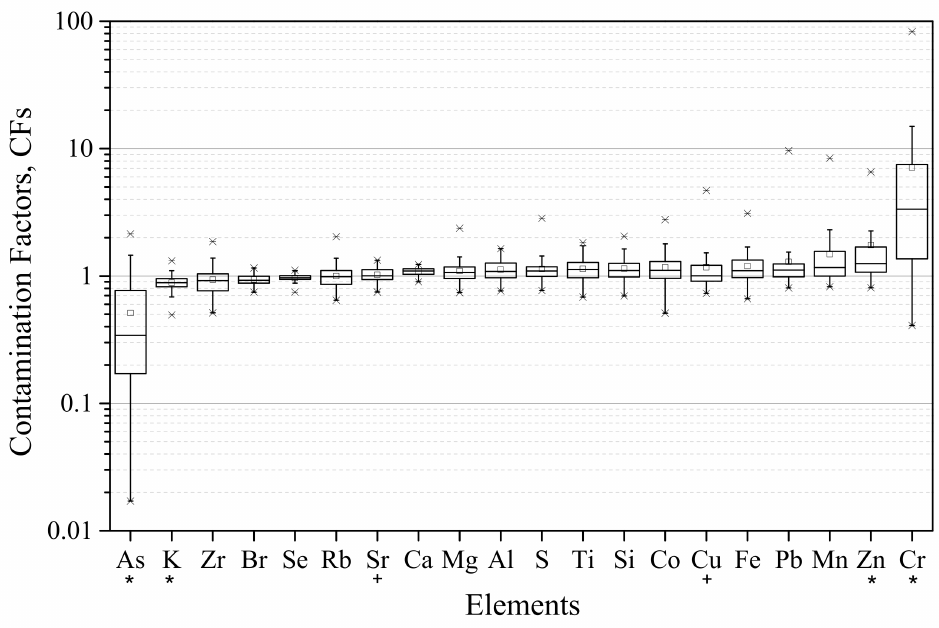
Figure 5. Average CFs of the elements present in the exposed samples. *–Significant statistical differences between exposed and unexposed elemental contents of lichens by a Mann-Whitney U test, at 0.05 significance level. +—Not significant statistical difference between exposed and unexposed elemental contents of lichens by the One Sample Wilcoxon test, at 0.05 significance level. Regarding the box plot, the square represents the mean, upper and lower times sign ( × ) shows the maximum and minimum values, the box provides the 25 percentile, the median and the 75% percentile, and the lower and upper minus sign ( − ) shows the 5 and 95 percentiles,